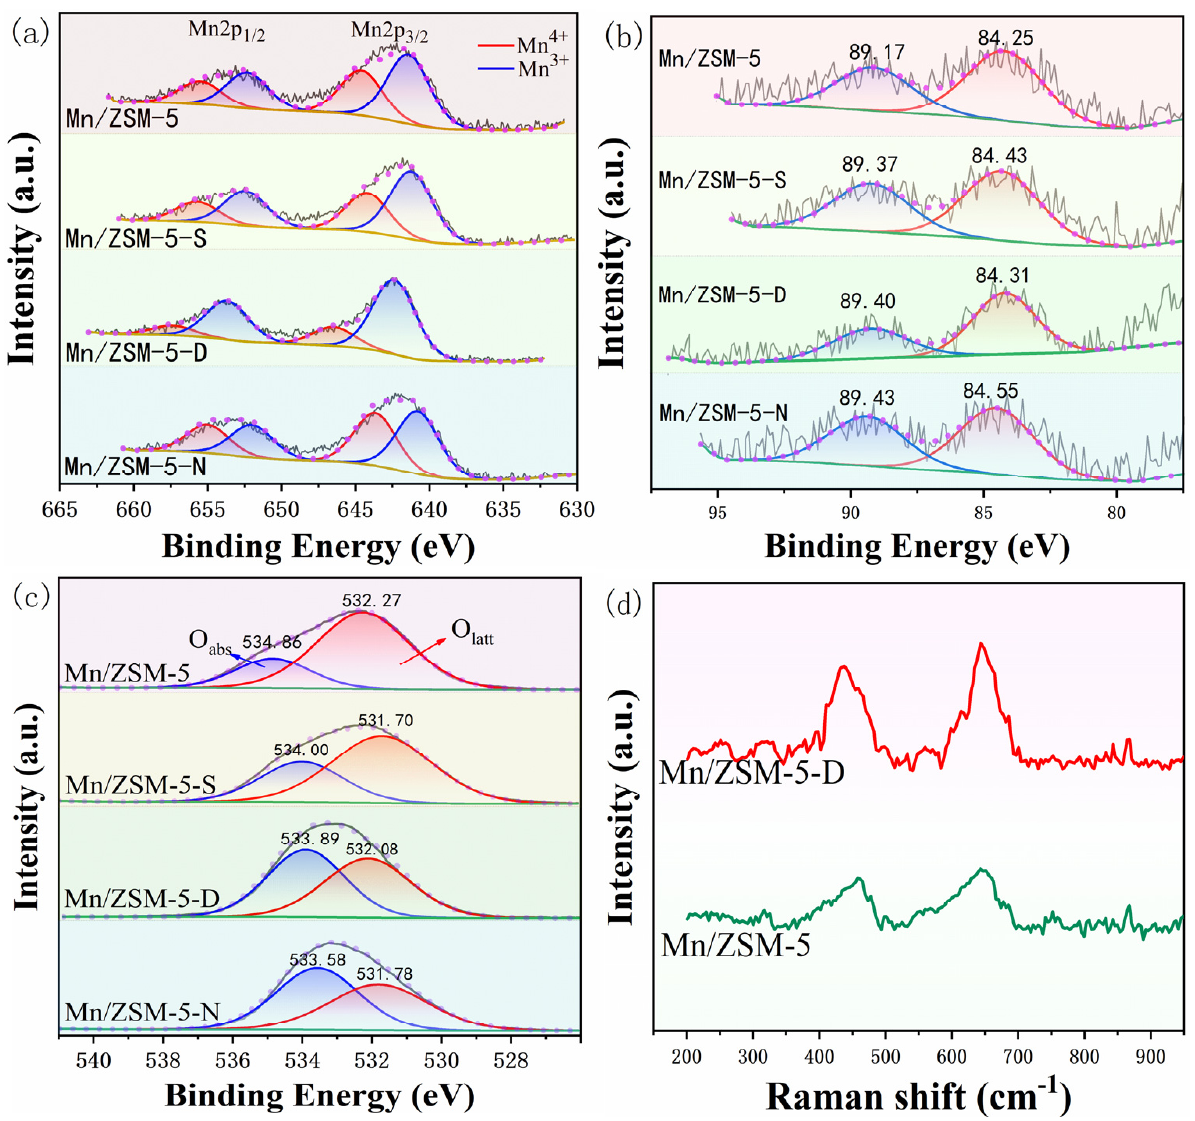
Figure 8. ( a ) Mn 2p, ( b ) Mn 3s, and ( c ) O 1s photoemission features from XPS results of Mn/ZSM ‐ 5 and modified catalysts, ( d ) Raman spectra of the Mn/ZSM ‐ 5 and Mn/ZSM ‐ 5 ‐ D.